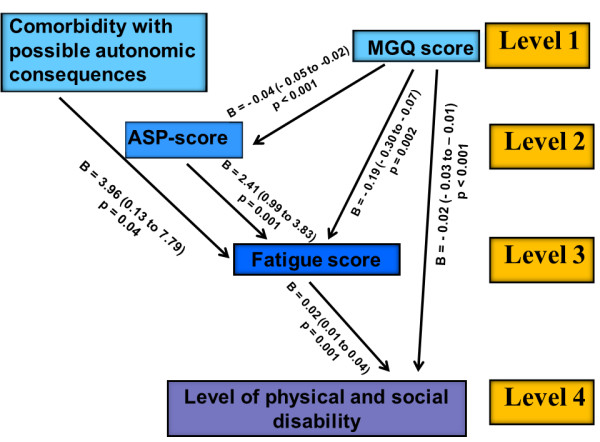
Results of multivariate analysis. The results are presented as regression coefficient B (95% confidence interval). ASP = autonomic symptoms profile.